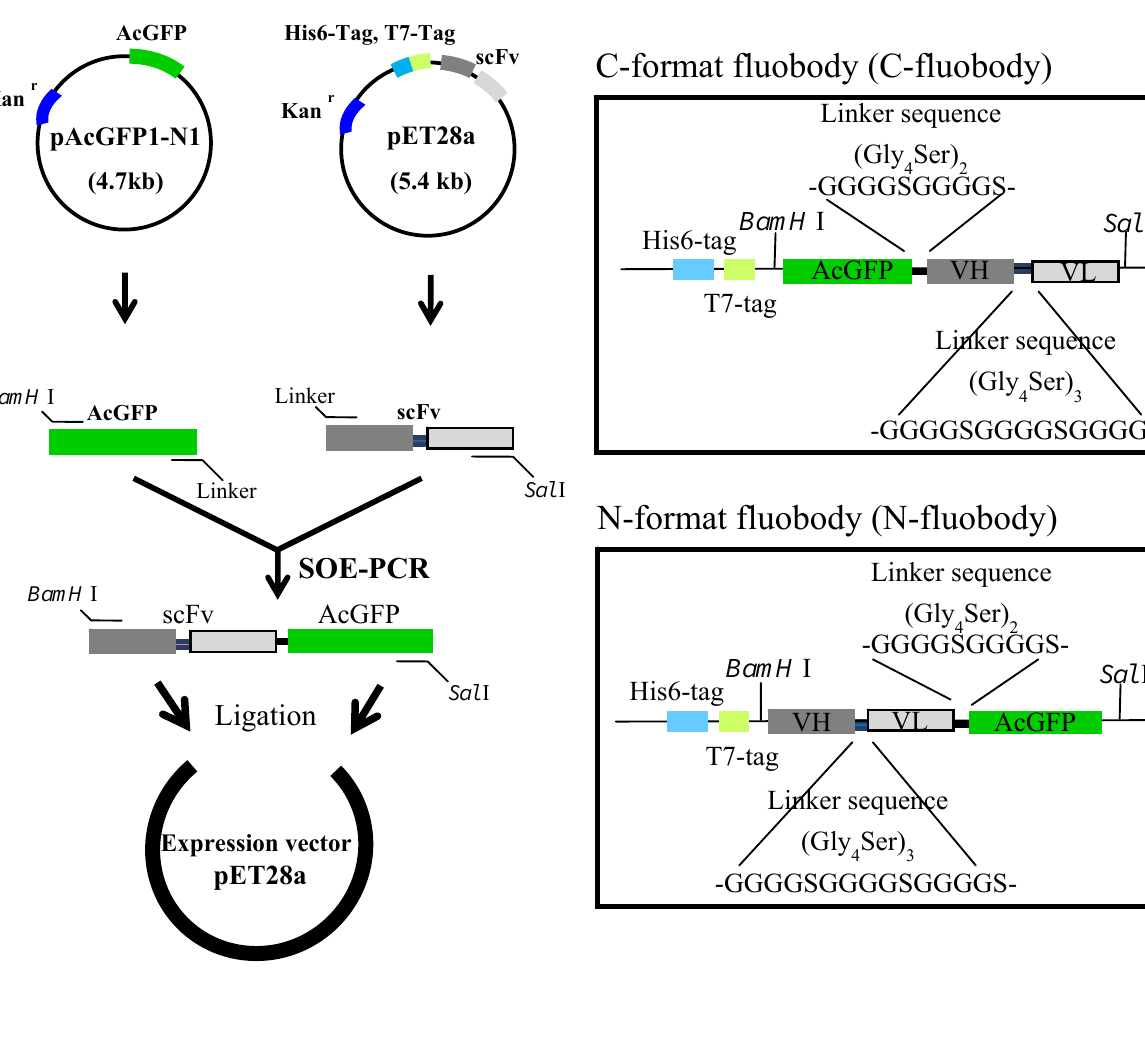
Figure 2. Schematic diagram of the construction of fluobody. The AcGFP and scFv genes were fused by splicing by overlap extension PCR (SOE-PCR) with the flexible linker sequence consisting of repetitive sequence of glycine and